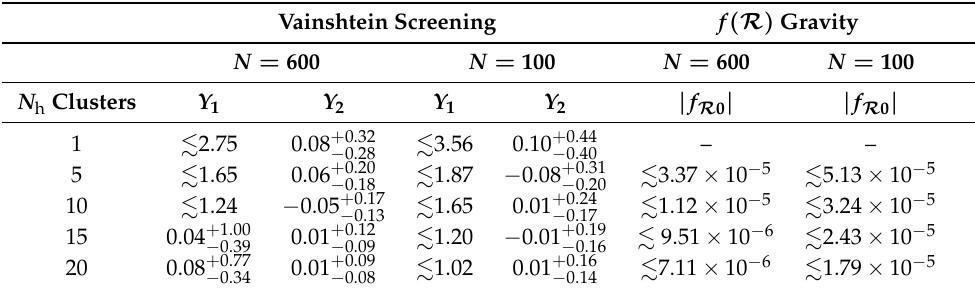
Figure 1. Results for the MG-MAMPOSS T and lensing forecast in VS for one halo in the sample. ( Bottom-left plot ): confidence regions in the space ( Y 1 , Y 2 ). Dark and light red areas and green and black contours represent the 1 σ and 2 σ regions for the internal kinematic and lensing analysis with 600 tracers and for the lensing simulation only, respectively. ( Upper and bottom-right plots ): marginal posteriors of Y 1 and Y 2 . Red lines are for the lensing and kinematics analysis with N = 600 tracers, blue dashed curves are for the case with N = 100 tracers and green dash-dotted curves show the lensing-only distributions. The GR expectation (i.e., Y 1 = Y 2 = 0) is indicated by the black vertical dashed lines. From [22]. Table 1. Constraints at 95% C.L obtained for the parameters of the two modified gravity models presented in this work applying the MG-MAMPOSS T fit with additional lensing information over the mock catalogue of synthetic halos with r 200 = 2.0Mpc and r s = 0.3Mpc. From column two to column six: Vainshtein screening. Column seven and eight: scalaron field in general chameleon f ( R ) gravity, related to chameleon field φ ∞ through Equation (13). For both models we show the results when using ∼ 600 and ∼ 100 cluster members in the MG-MAMPOSS T